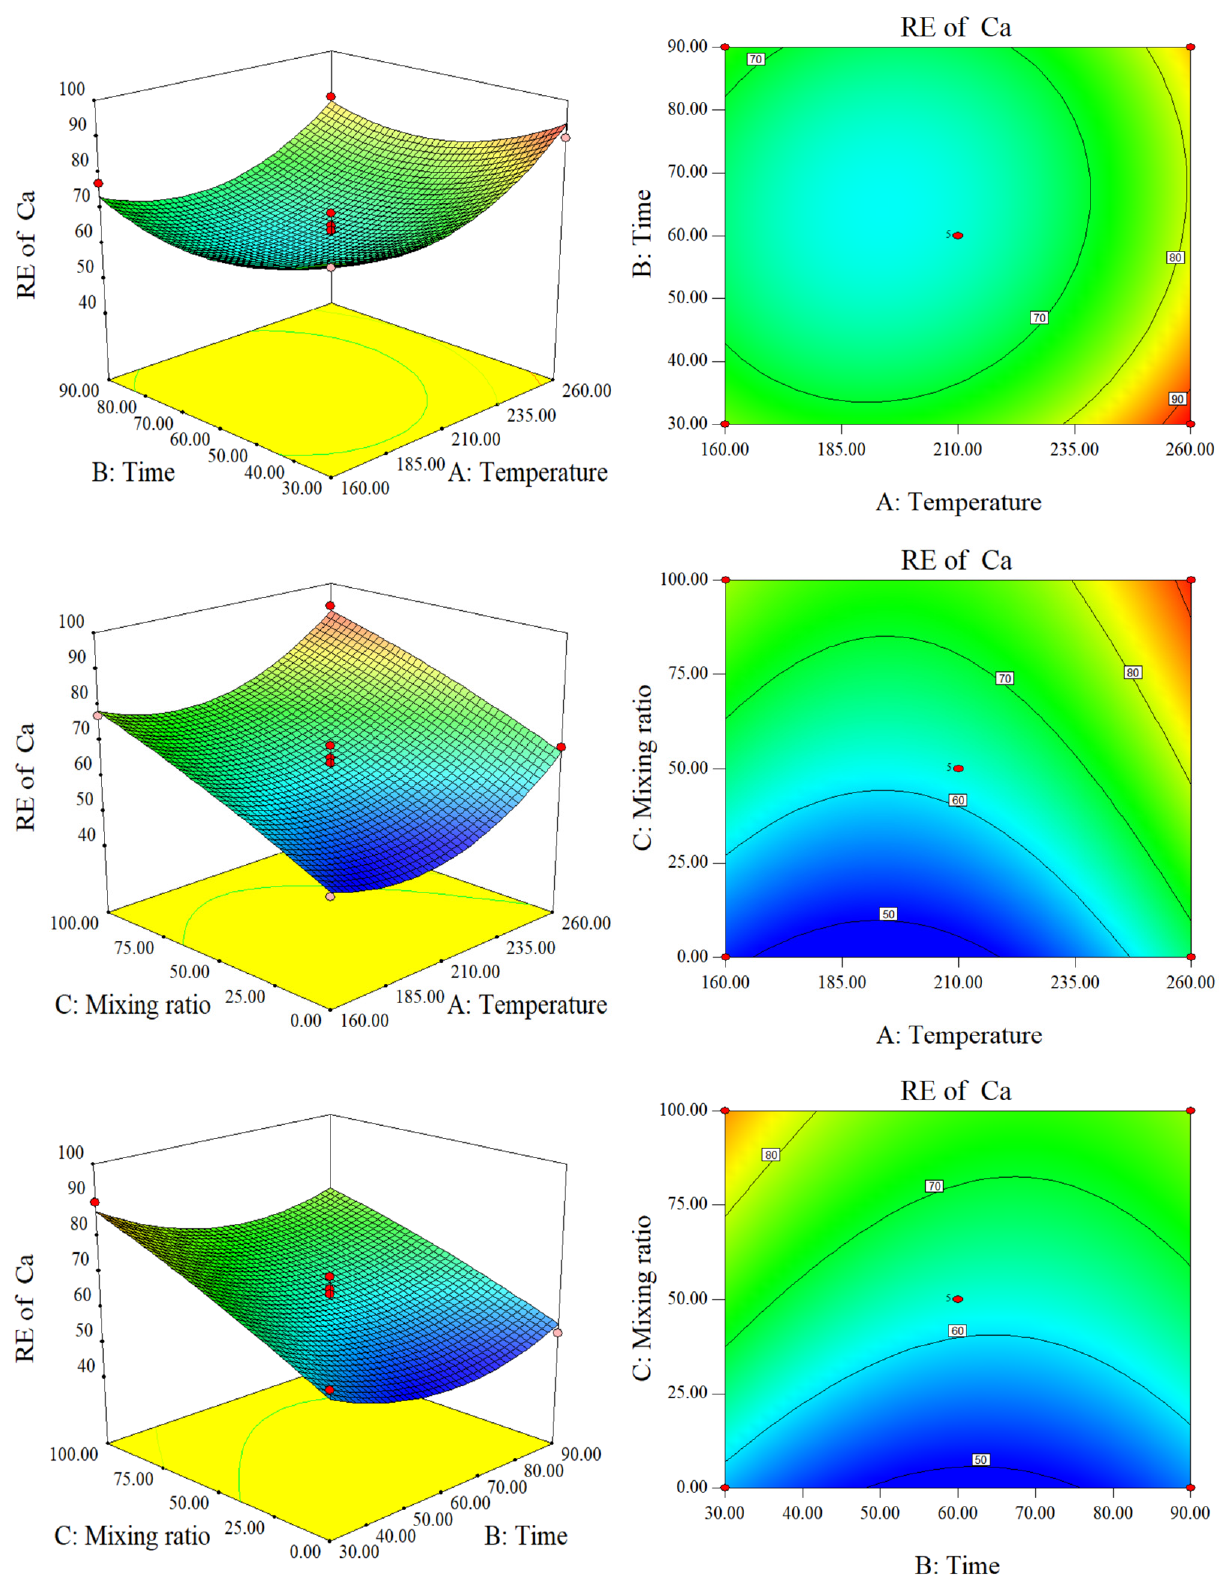
Figure 6. Response surface plots and contour plots of the RE of Ca.